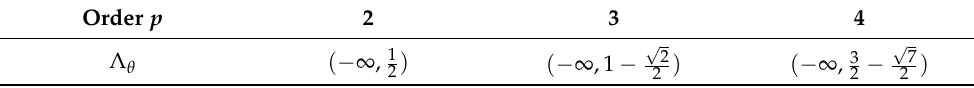
Table 1. Explicit form of Λ θ